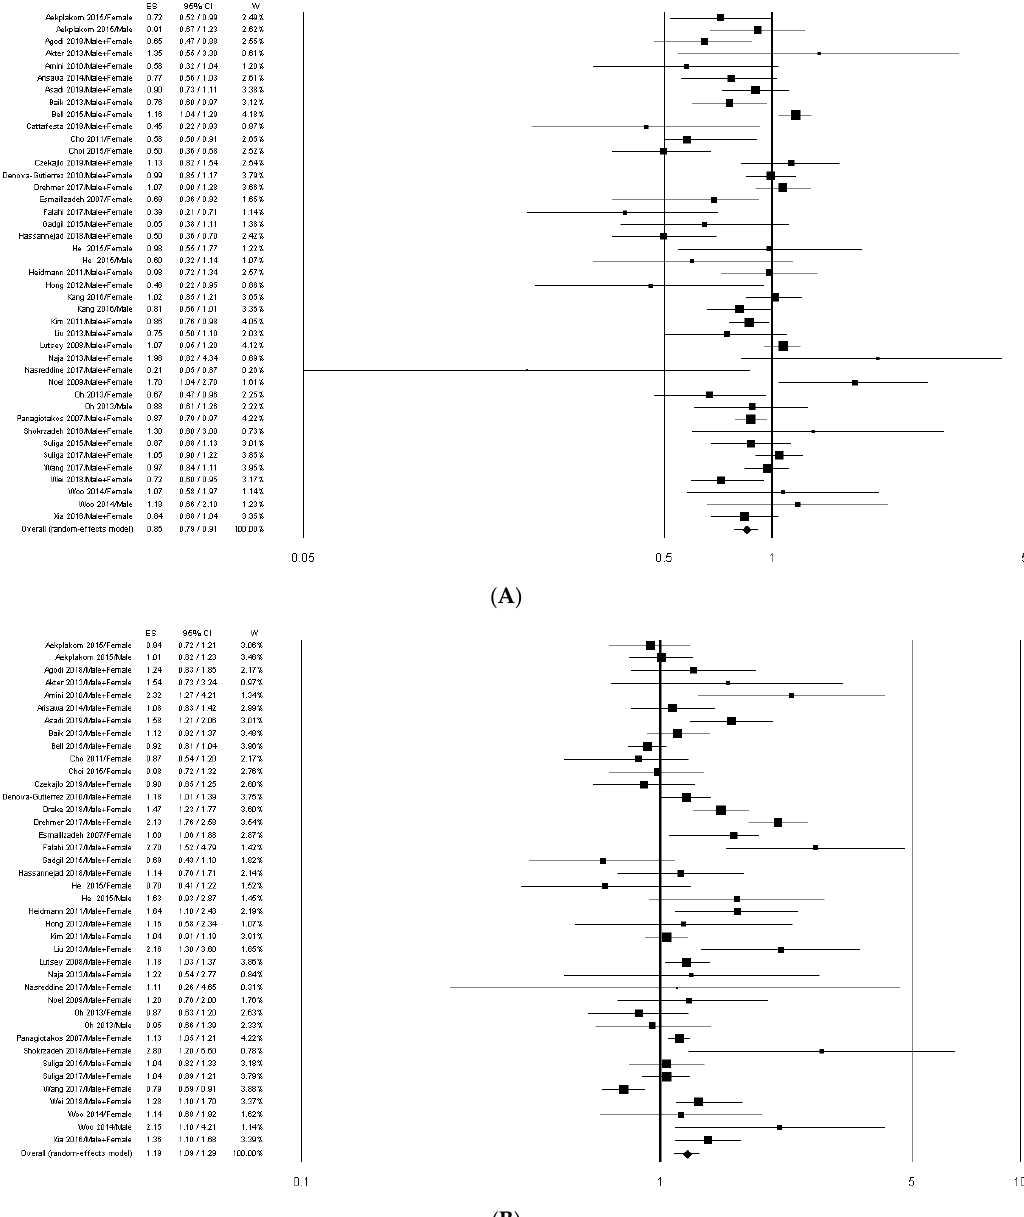
Figure 2. Forest plots of the association between “Healthy” ( A ) and “Meat/Western” ( B ) dietary patterns and MetS risk. ES, effect size.